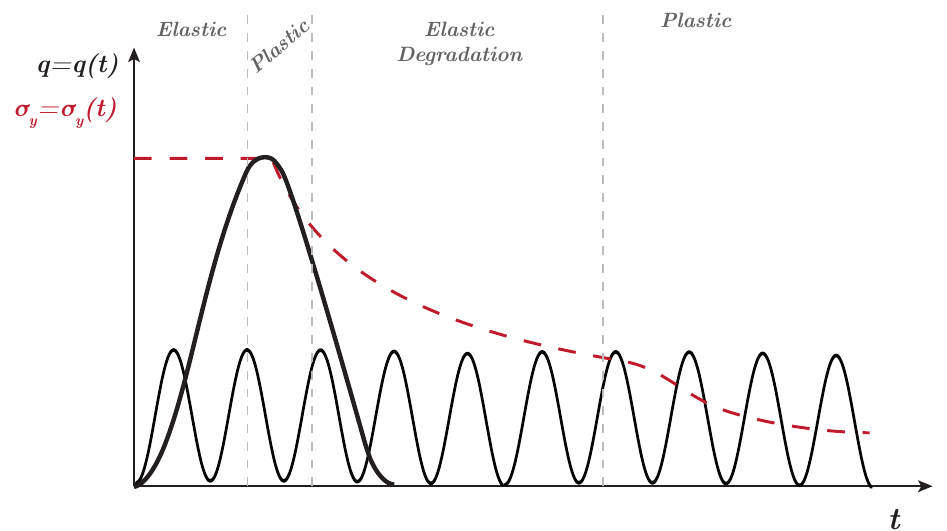
Figure 12. Scheme of the load and the yield strength along the